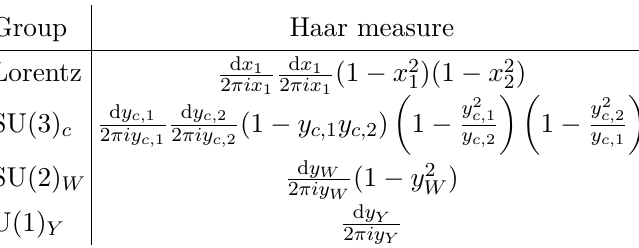
Table 5 . List of Haar measures used to calculate the Hilbert series. See the caption of table 4 for the definition of